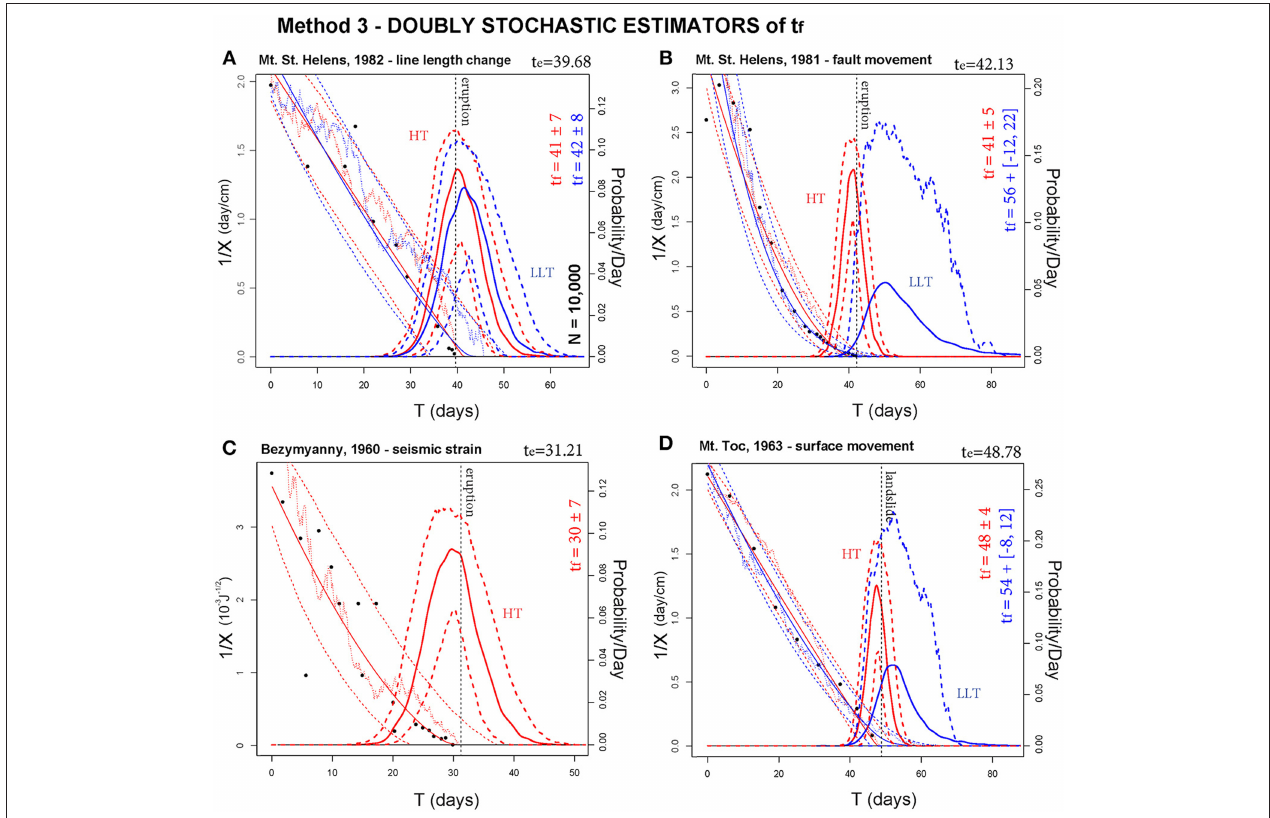
FIGURE 6 | Estimators of t f based on Method 3. In (A–D) are reported four different case studies. Blue lines assume α as from LLT, red as from HT. A bold line is g t and bold dashed lines are its 5th and 95th percentile values. The probability/day scale bar is related to g t confidence interval of the SDE paths of 1 / X , and a thin continuous line is the mean path. Thin dotted lines show examples of random paths. Black points are inverse rate data. A dashed black line marks t e . Method 3 enhances Method 2 and performs significantly